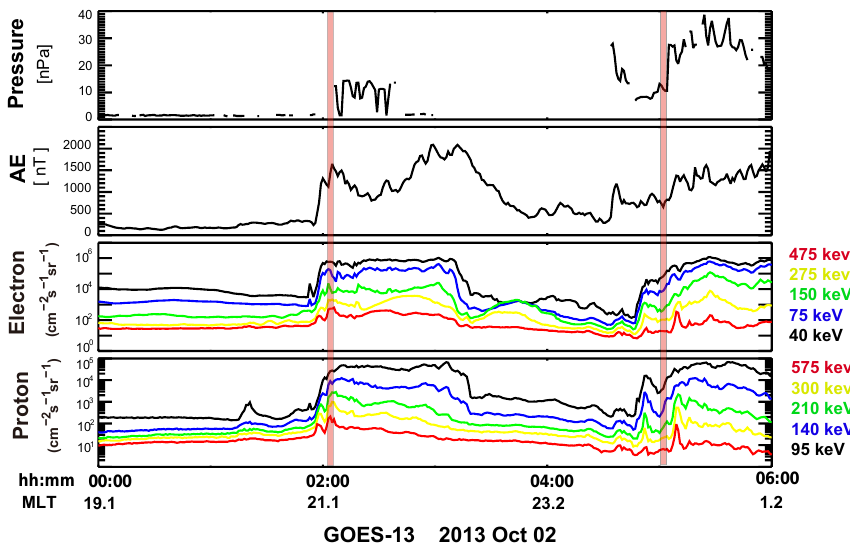
Figure 2. Time series of electron and proton fluxes observed by GOES-13 between 00:00 and 06:00UT on 2 October 2013. From top to bottom: solar wind dynamic pressure, AE index, electron fluxes of five color-coded energy channels, and proton fluxes of five color-coded energy channels. The two vertical lines present the two intense P dyn enhancements.